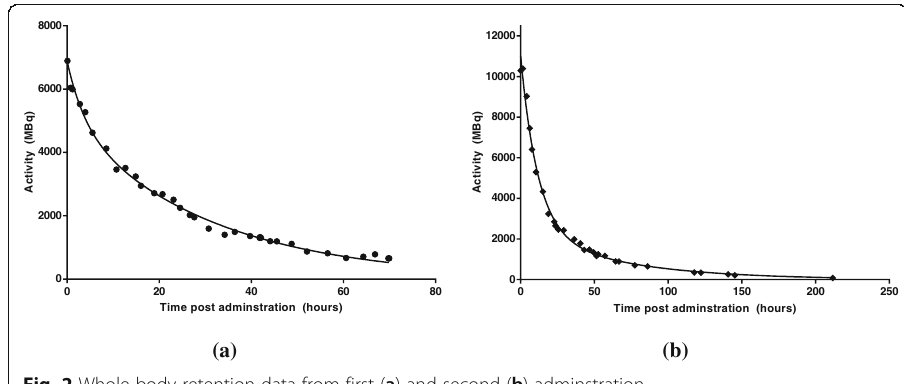
Fig. 2 Whole-body retention data from first ( a ) and second ( b ) adminstration